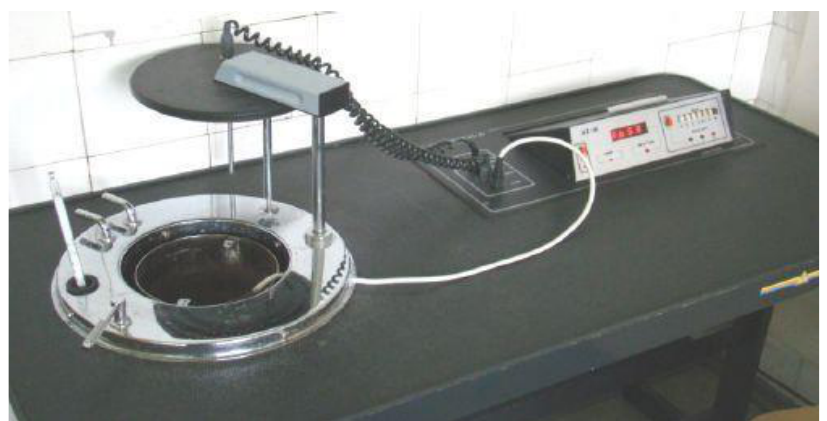
Figure 3. A sample graph of the calorimetric measurement for the calorimeter KL-10.